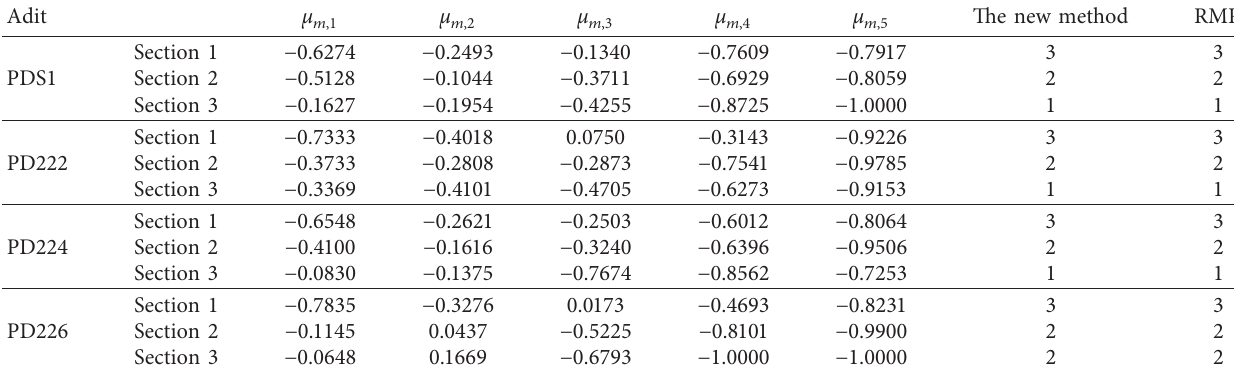
Table 9: The results of rock mass